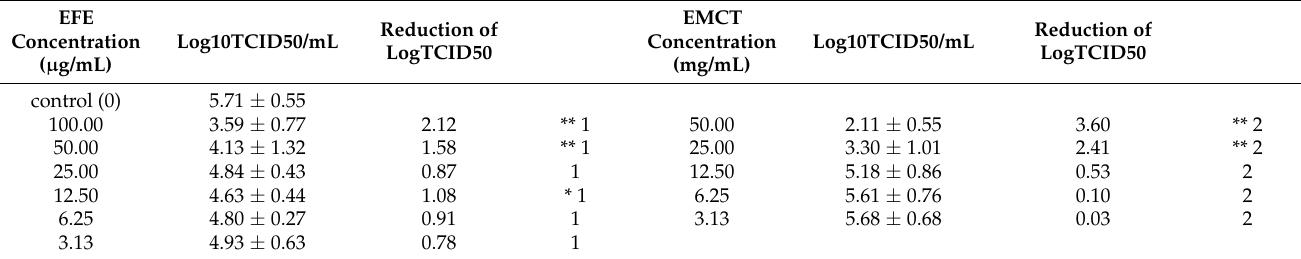
Table 2. Reducation of log10TCID50 of SARS-CoV-2(WK-521 strain) within culture supernatant at 24 hours post infection treatment with EFE or EMCT after